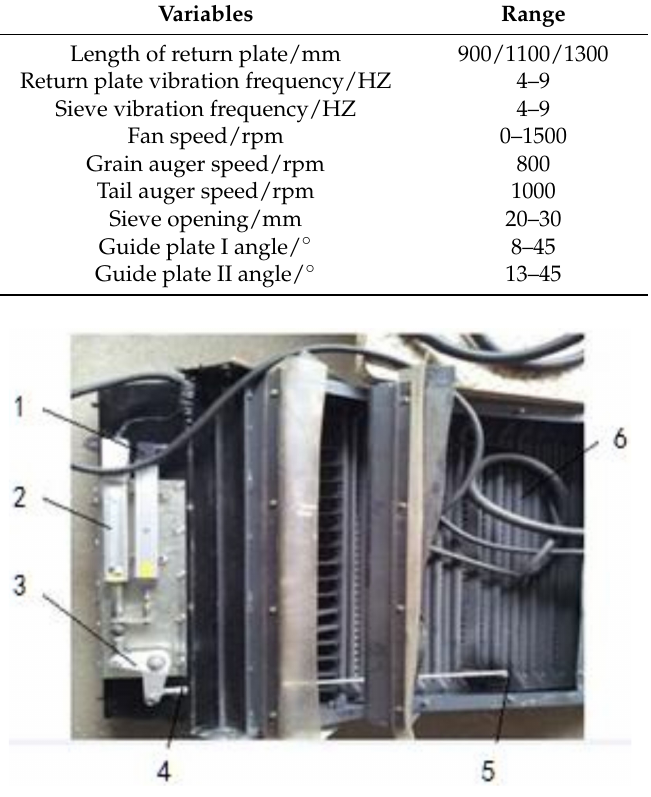
Figure 3. Working principle of the sieve-opening adjusting system. 1. Displacement sensor, 2. Push rod, 3. Direction converter, 4. Joint bearing, 5. Connecter, 6. Active